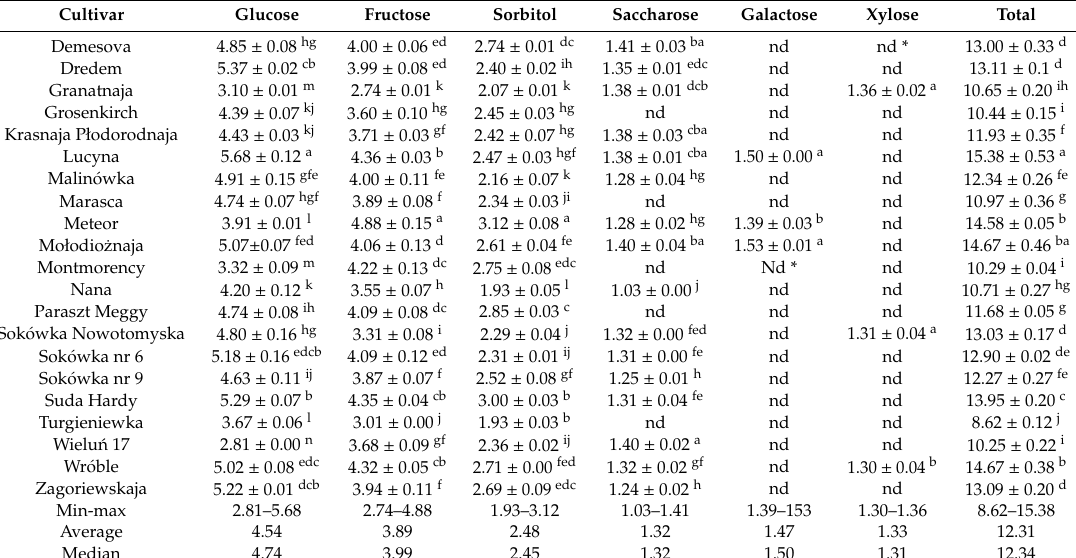
Table 1. Sugar content (g / 100 g FW) in sour cherry fruit of 21 cultivars. Glucose Fructose Sorbitol